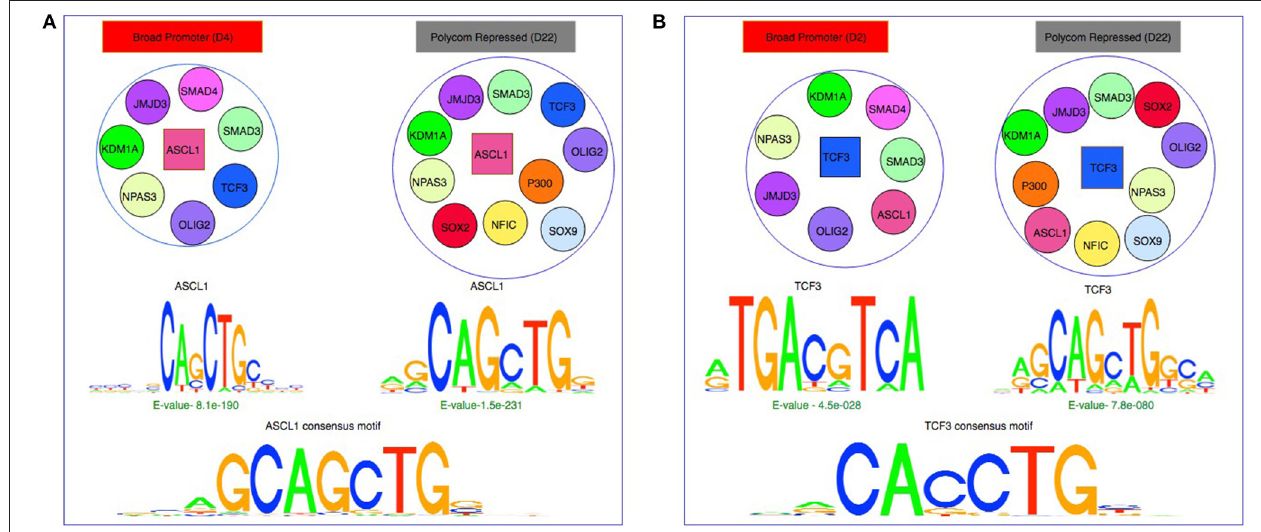
FIGURE 5 | Effect of chromatin states and co-binding partner on binding motifs. (A) De-novo motifs obtained using MEME for ASCL1 are similar to the consensus motif in both Broad Promoter and Polycomb Repressed states although the co-factors of ASCL1 are different in the two states. (B) De-novo motifs obtained using MEME for TCF3 show differences in motifs between the two states with different co-factors. The motifs in active state resemble the β -catenin/TCF/LEF motif whereas the motifs in repressed state resemble the E-Box consensus motif.